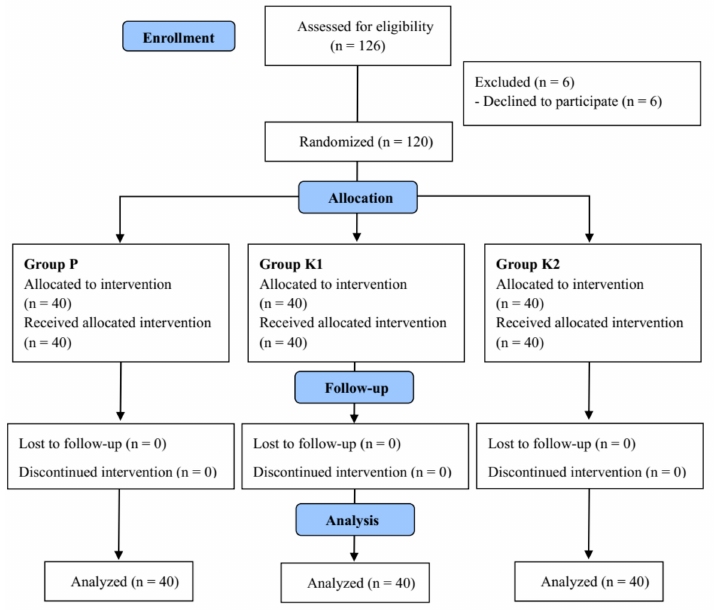
Figure 1. Consolidated Standards of Reporting Trials (CONSORT) flow